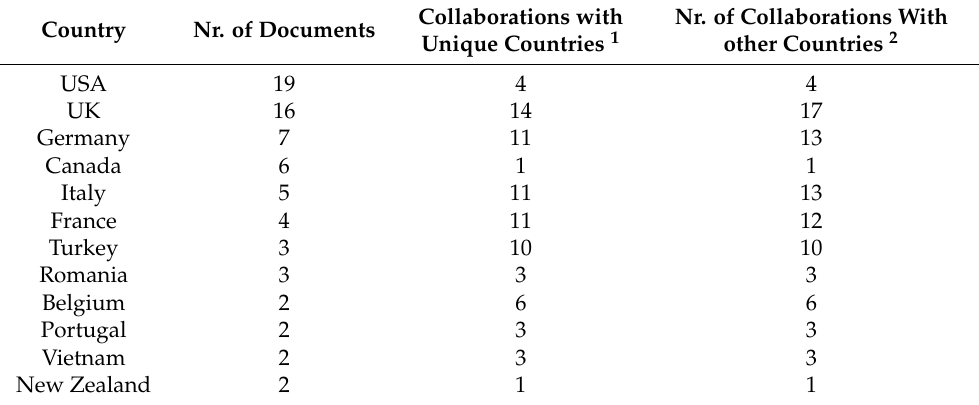
Table 11. Top countries (Nr. of documents > 5) in the period 2018 – 2022. Country Nr. of Documents